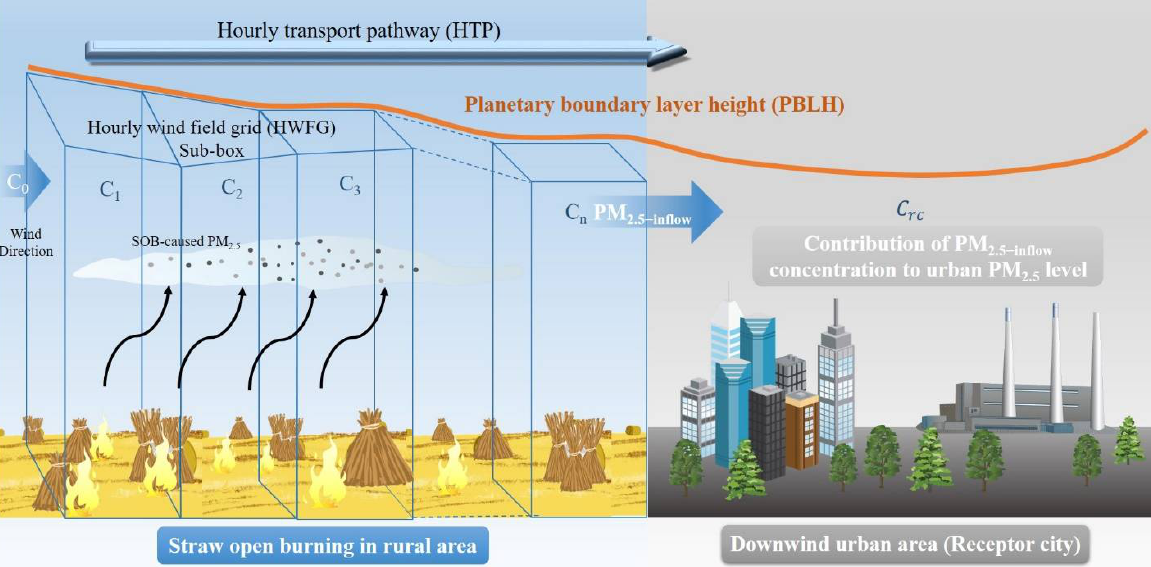
Figure 4. Schematic diagram of two-stage spatiotemporal multi-box modeling based on hourly wind-field grids.